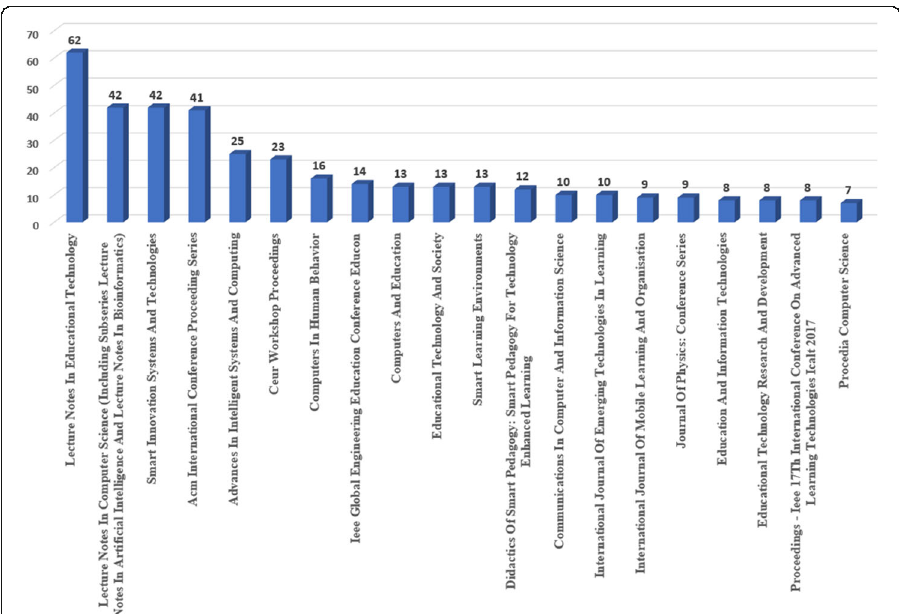
Fig. 2 Distribution of articles by relevant sources from 2002 to mid-2020. (Based on this study ’ s Scopus dataset, lecture noted in educational technology remains the top source for smart learning environment